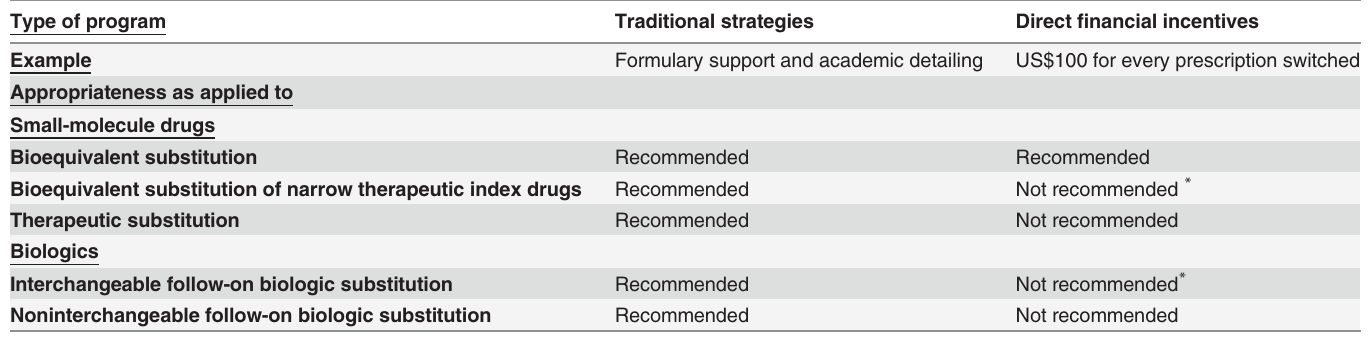
Table 2. Authors ’ evaluation of physician-centered strategies to promote generic drug and follow-on biologic prescribing